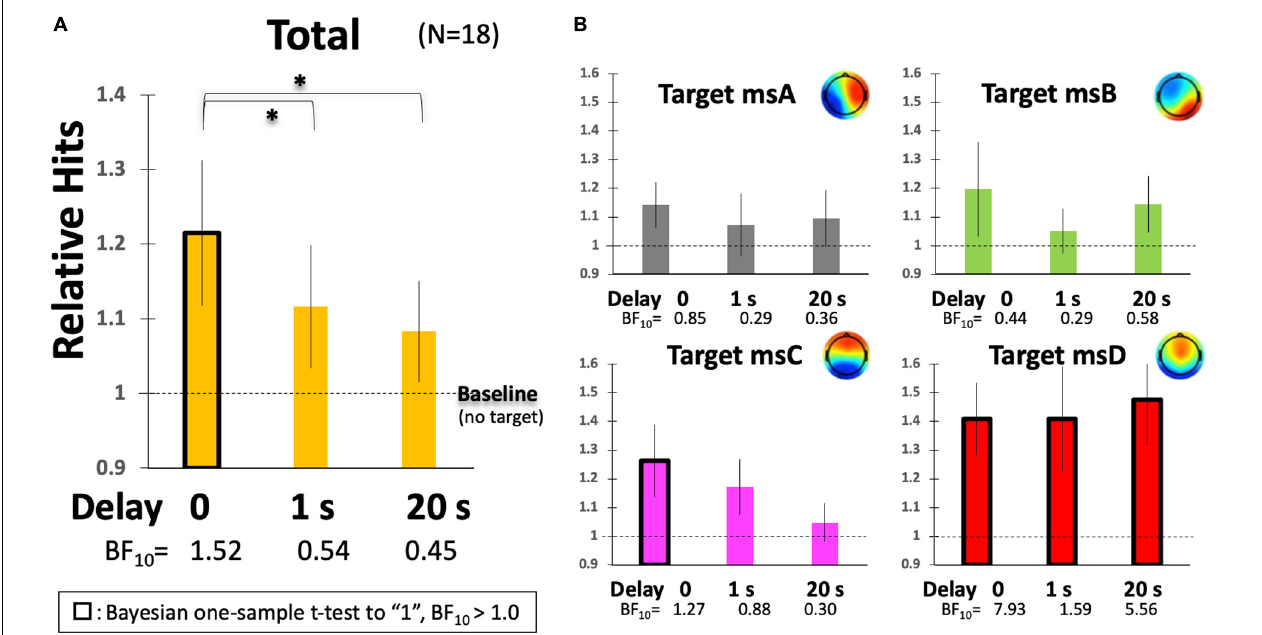
FIGURE 7 | Participants’ Hit performance as a function of delay. (A) The relative magnification of total Hits in comparison to the individual baseline (no-target condition). (B) The same indices are calculated, respectively, for msA, B, C, and D. Error bars indicate ± 1 SE. * p < 0.05 in ANOVA.